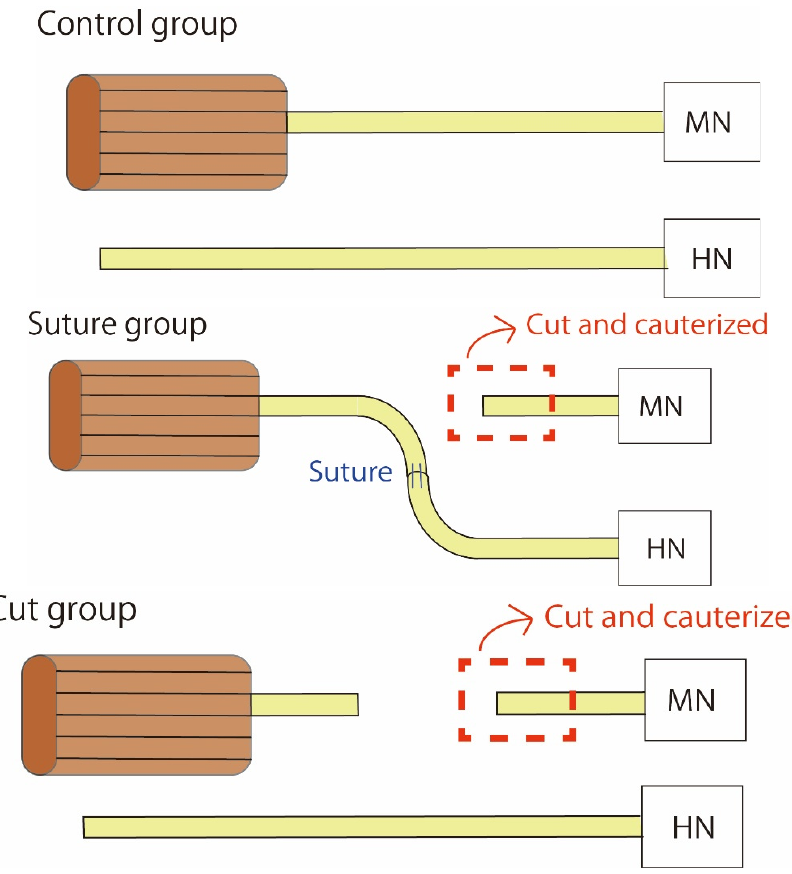
Figure 8. Schema of the experiment. No surgery was performed in the control group. In the suture group, MN was cut, and its distal stump and the proximal stump of HN were sutured. In the cut group, MN was just cut and cauterized. MN: masseteric nerve, HN: hypoglossal nerve.